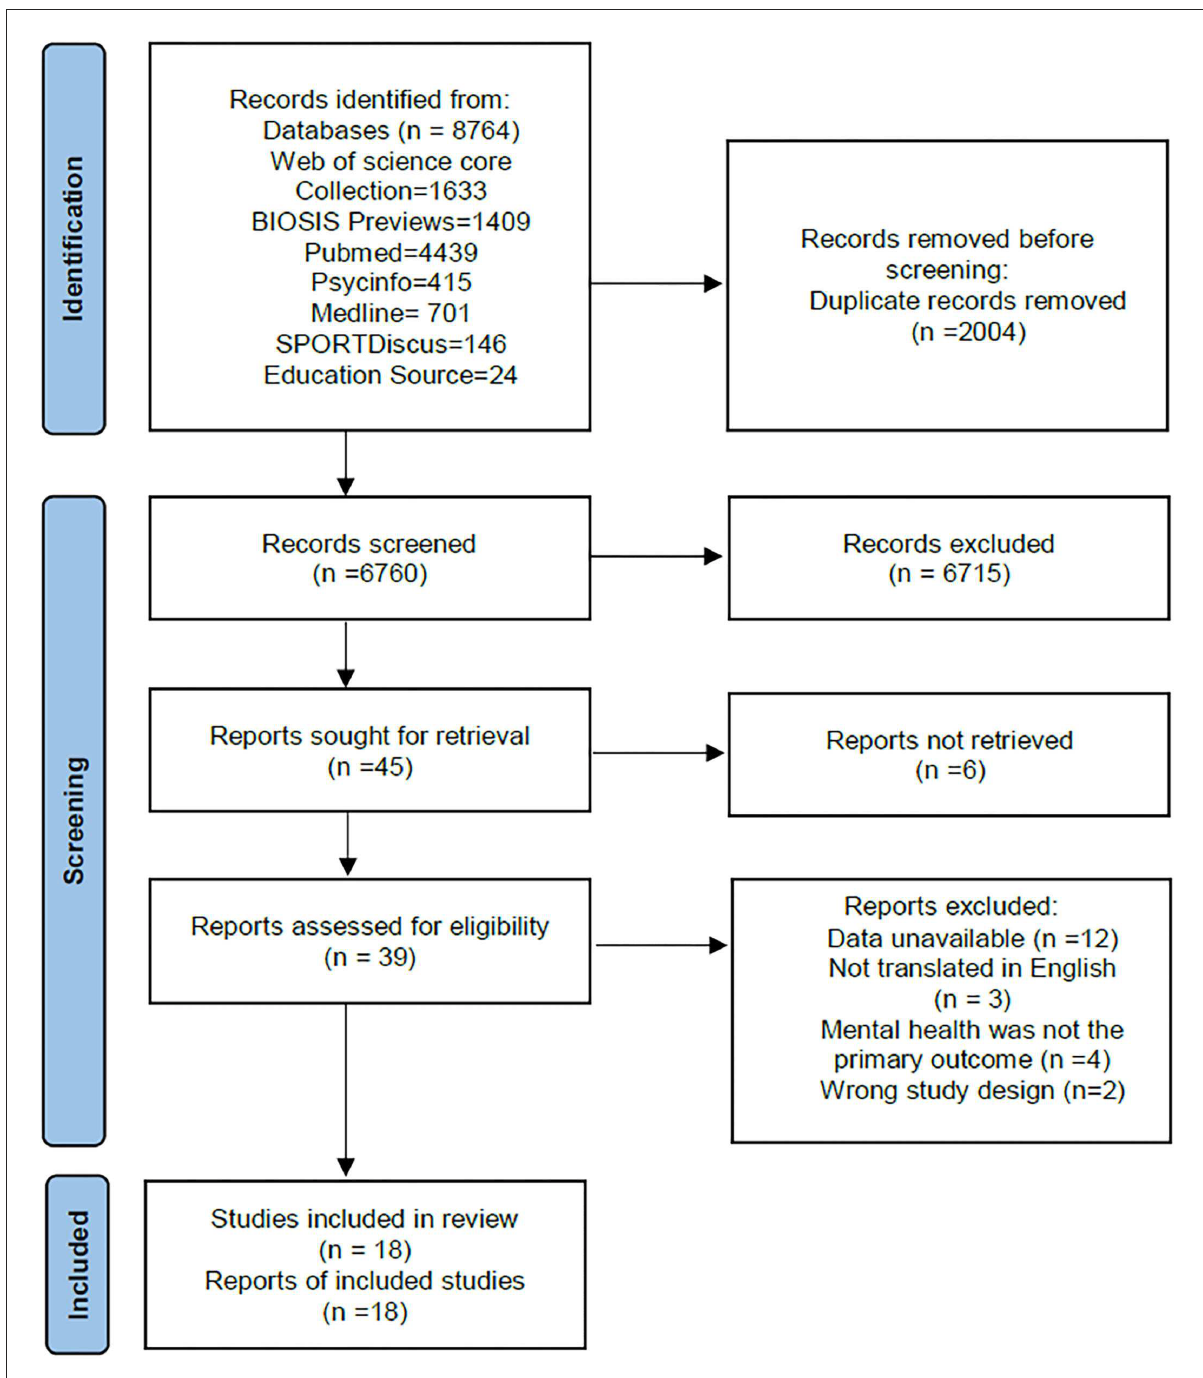
FIGURE1 PRISMA flow chart. The figure shows the search strategy and selection of articles in this study (18 articles were included at the end).